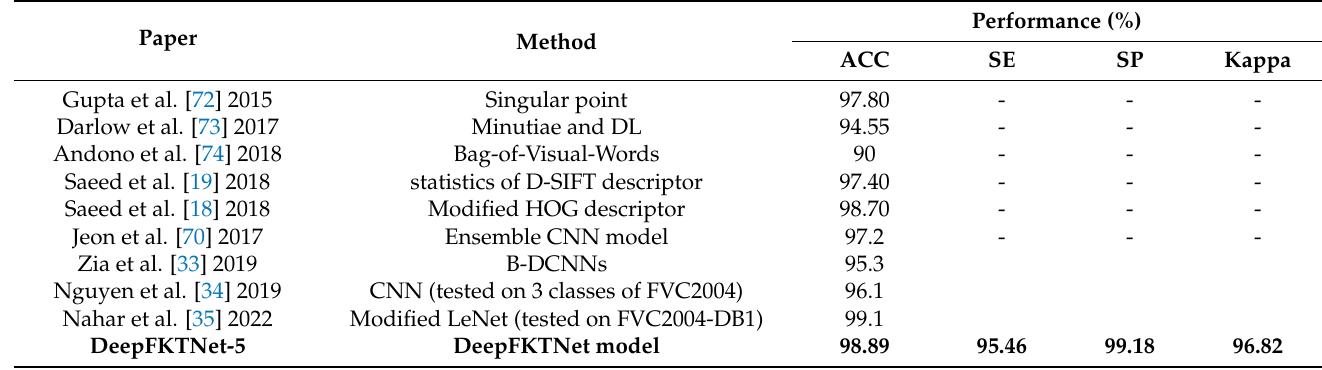
Table 5. Comparison between DeepFKTNet-5 and the state-of-the-art